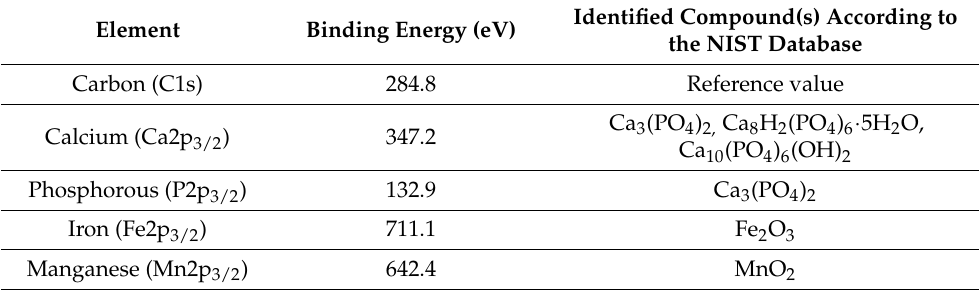
Table 6. The binding energies of various elements on the fouled membrane (determined via XPS analysis).